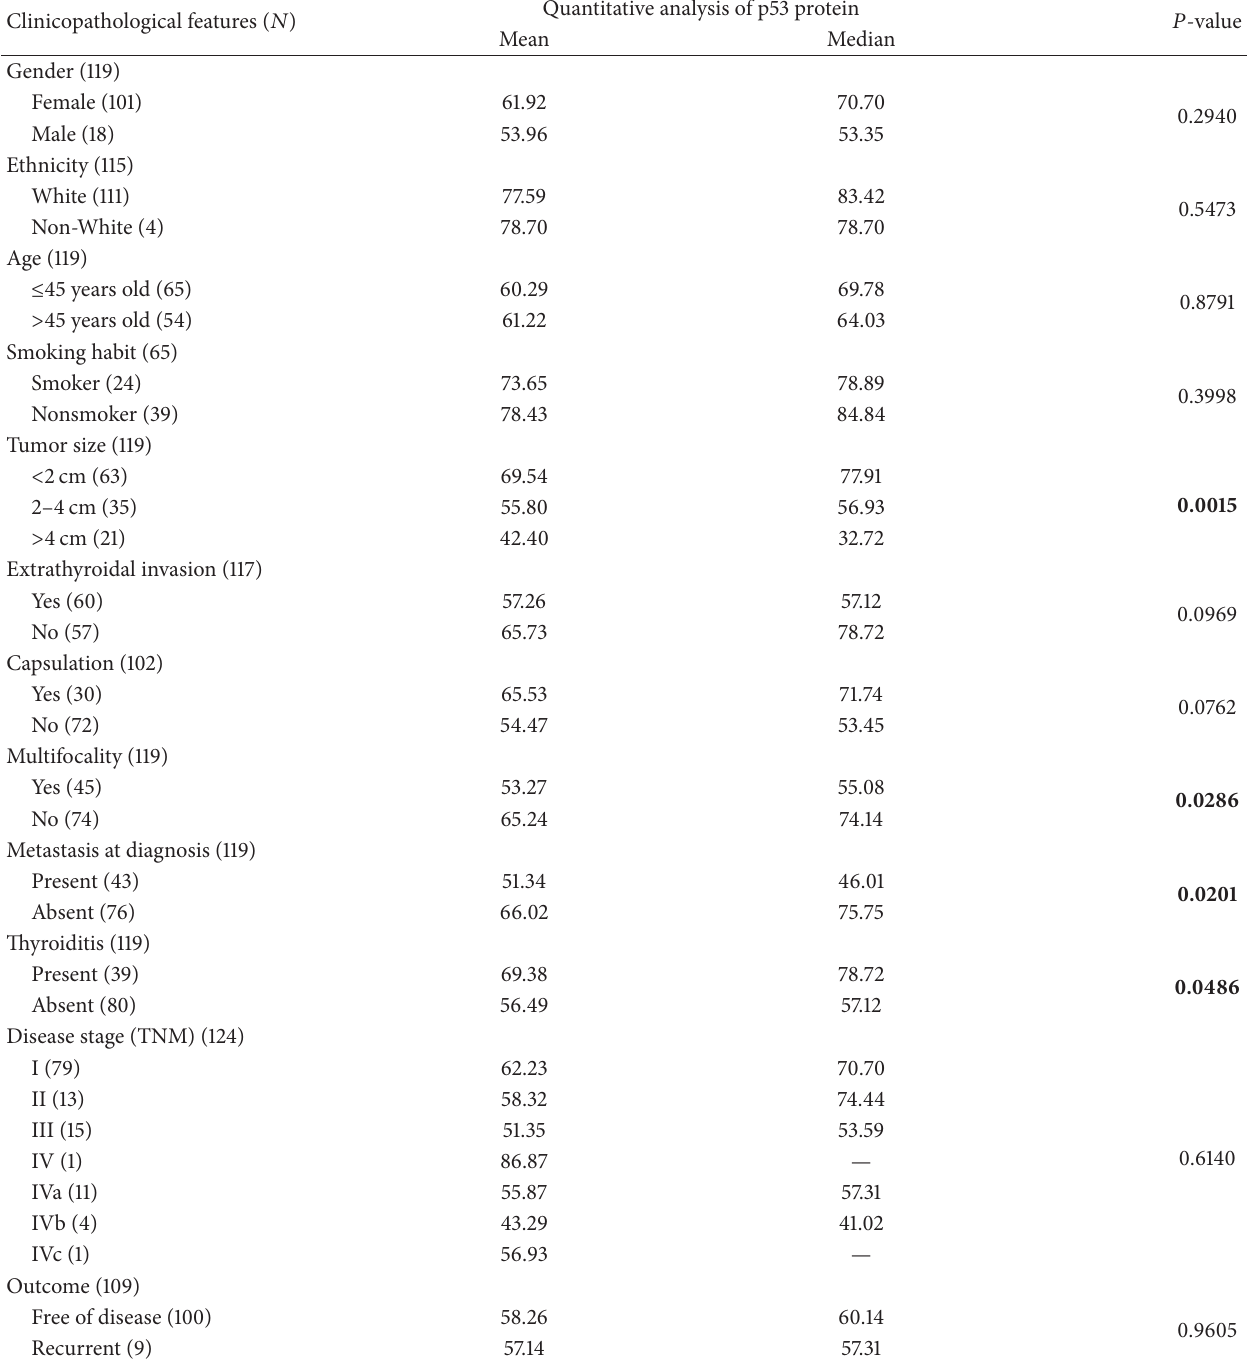
Table 2: Immunohistochemical expression of p53 protein identified as positive, using automated cellular imaging system ACIS-III quantitative analysis, according to clinicopathological features of aggressiveness and patient